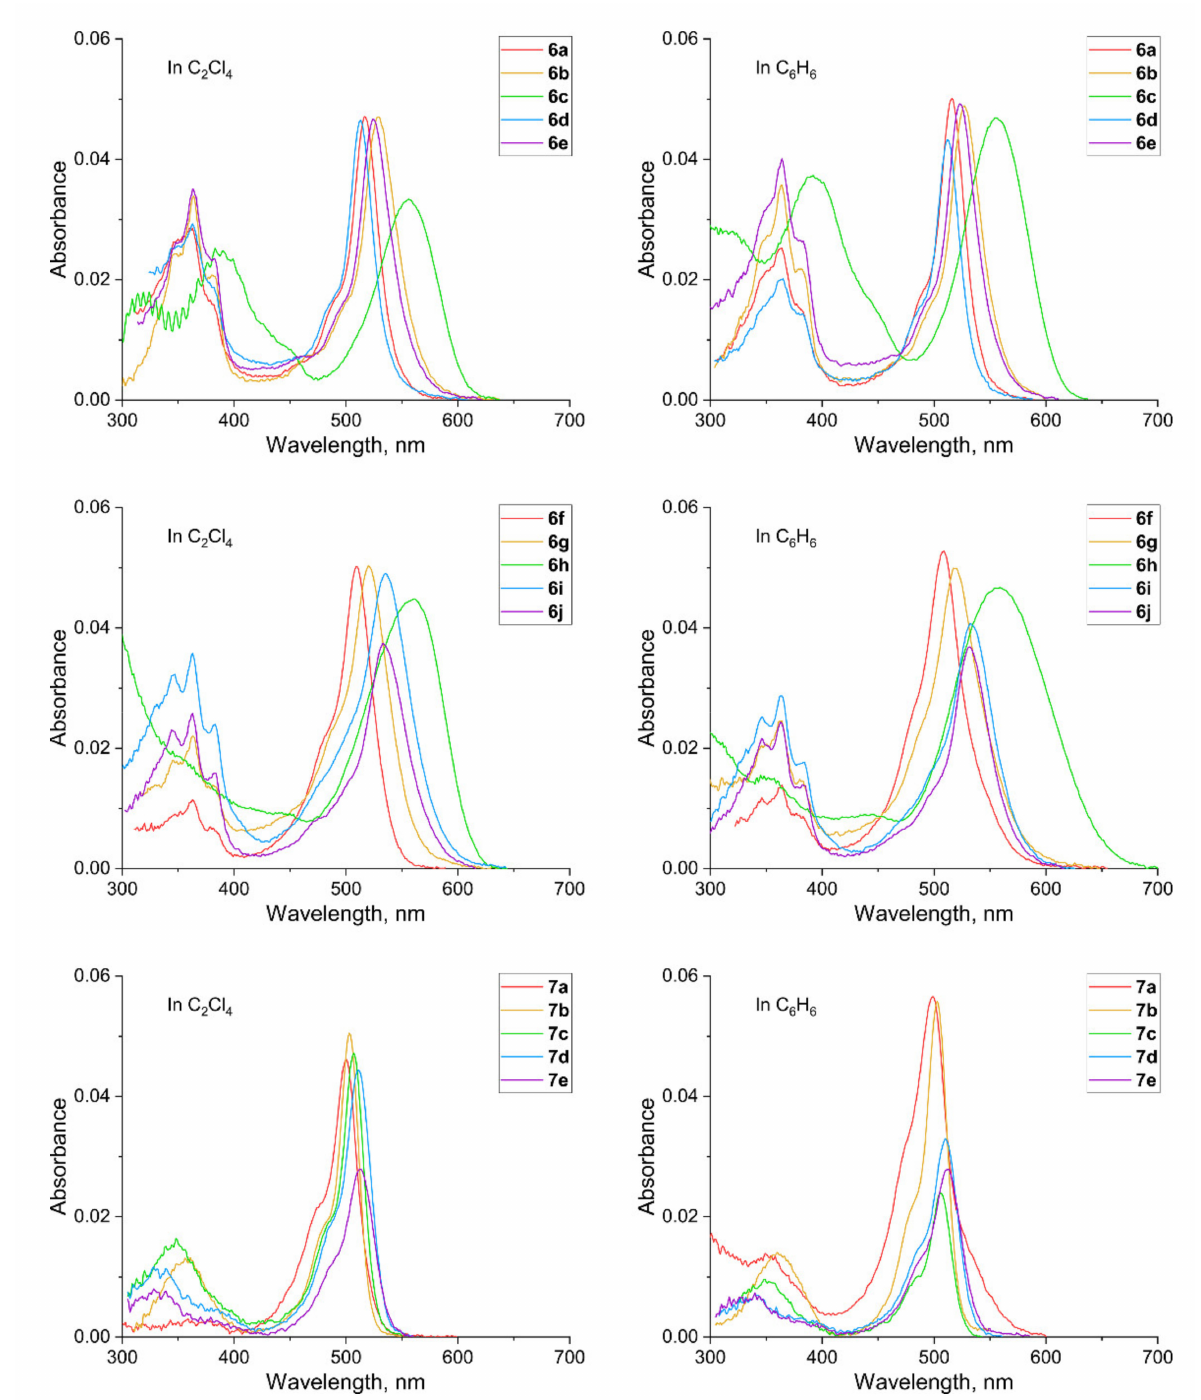
Figure 2. The absorption spectra of compounds 6a – j , 7a – e